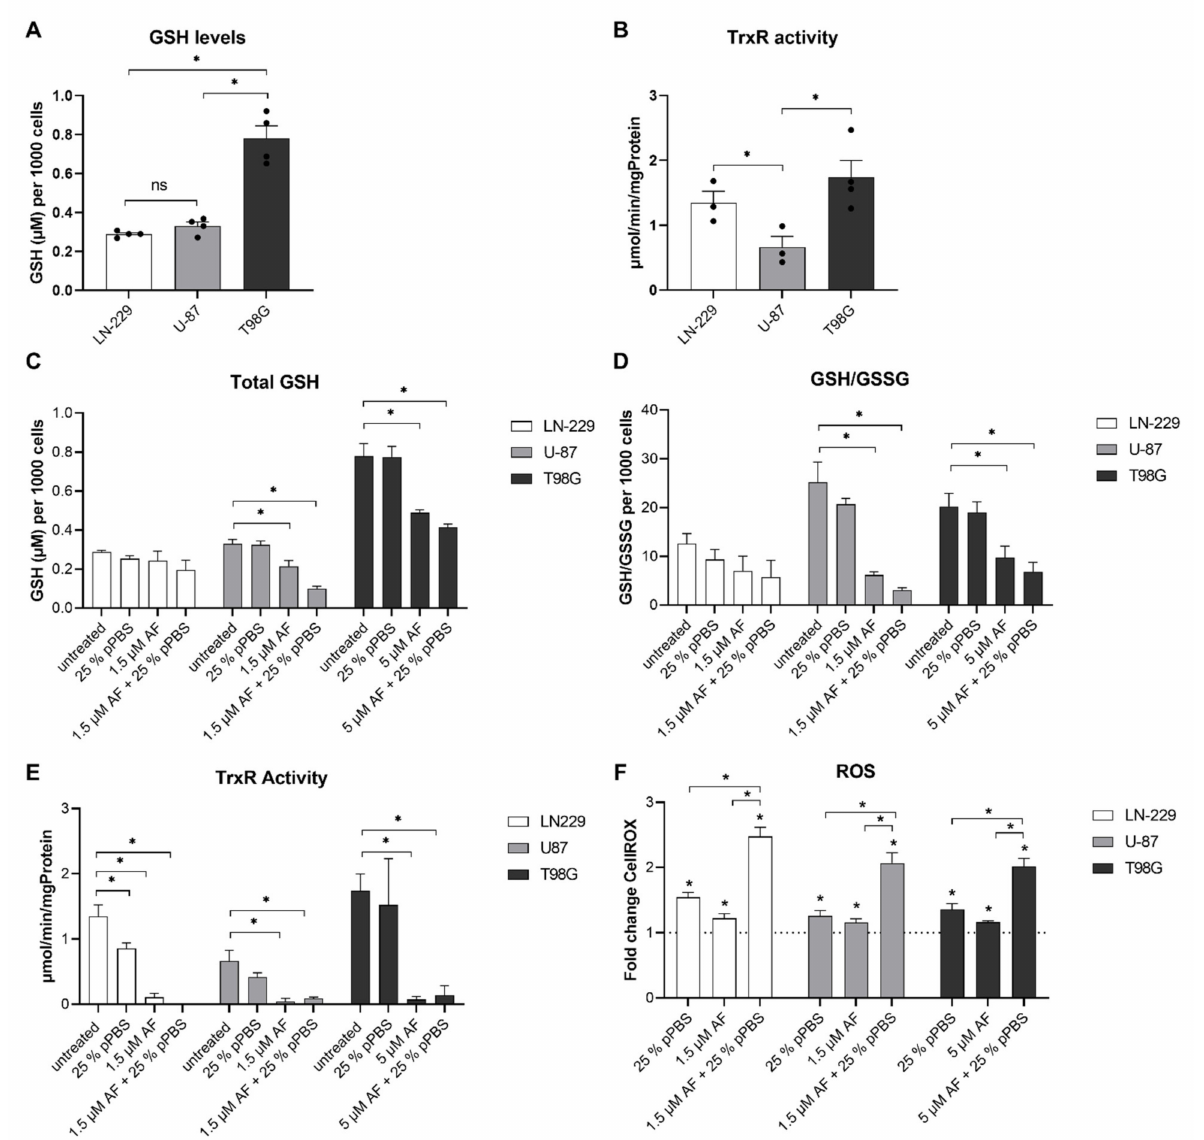
Figure 2. The effect of combination treatment of AF and pPBS on protein targets related to the antioxidant defense system. ( A ) Baseline GSH protein levels of LN-229, U-87 and T98G cells normalized towards 1000 cells ( B ) Baseline TrxR activity of LN-229, U-87 and T98G cells. ( C ) GSH protein levels normalized towards 1000 cells after 4 h of treatment with monotherapies and combination therapy of AF (1.5 µ M or 5 µ M) and 25% pPBS. ( D ) Ratio GSH/GSSG normalized towards 1000 cells after 4 h of treatment with monotherapies and the combination of AF (1.5 µ M or 5 µ M) and 25% pPBS. ( E ) TrxR activity after 4 h of treatment with monotherapies and combination therapy of AF (1.5 µ M or 5 µ M) and 25% pPBS. ( F ) Intracellular ROS levels shown as fold change of CellROX Calibration Units (CU), relative towards untreated after 4 h of treatment with monotherapies and combination therapy of AF (1.5 µ M or 5 µ M) and 25% pPBS. Graphs represent mean ± SEM of ≥ 3 independent experiments. * p ≤ 0.05 denotes a statistically significant difference compared with untreated control, ns denotes no statistical difference ( p >